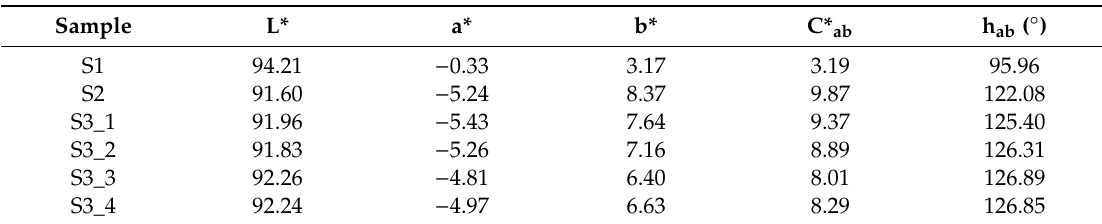
Table 4. The CIELAB color values, chroma (C* ab ) and hue (h ab ) of uncoated and coated samples before exposure to UVA light.